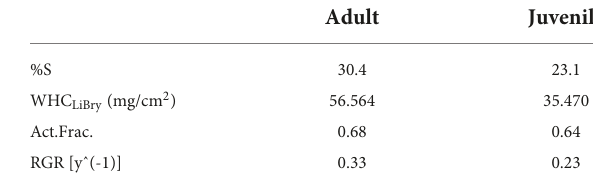
TABLE 2 Median values of the 9 simulated